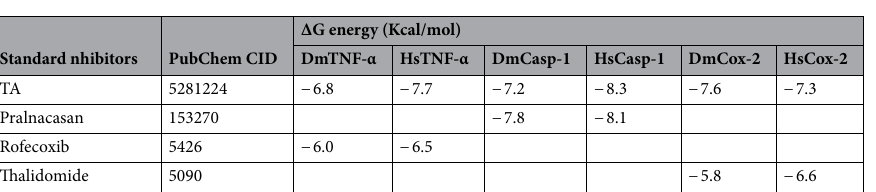
Table 1. Binding affinities of trans-astaxanthin (TA) and some standard inhibitors for the selected anti- inflammatory protein targets. Dm: Drosophila melanogaster ; hm: human, TNF-α: tumour necrosis factor-alpha